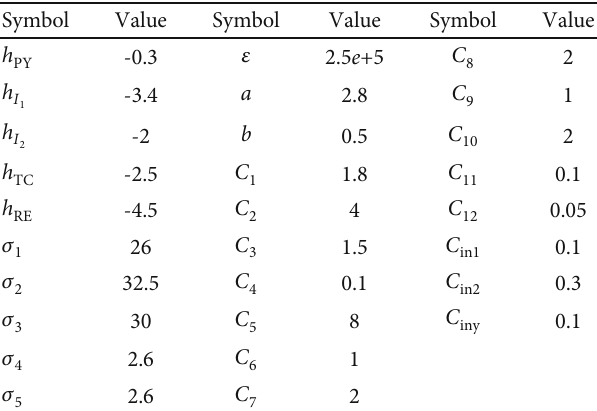
Table 1: Standard values of main model